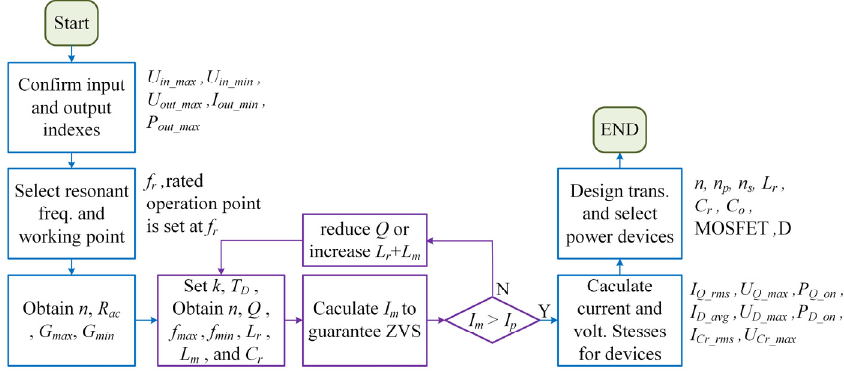
Figure 7. Design procedure of the proposed full-bridge LLC converter.